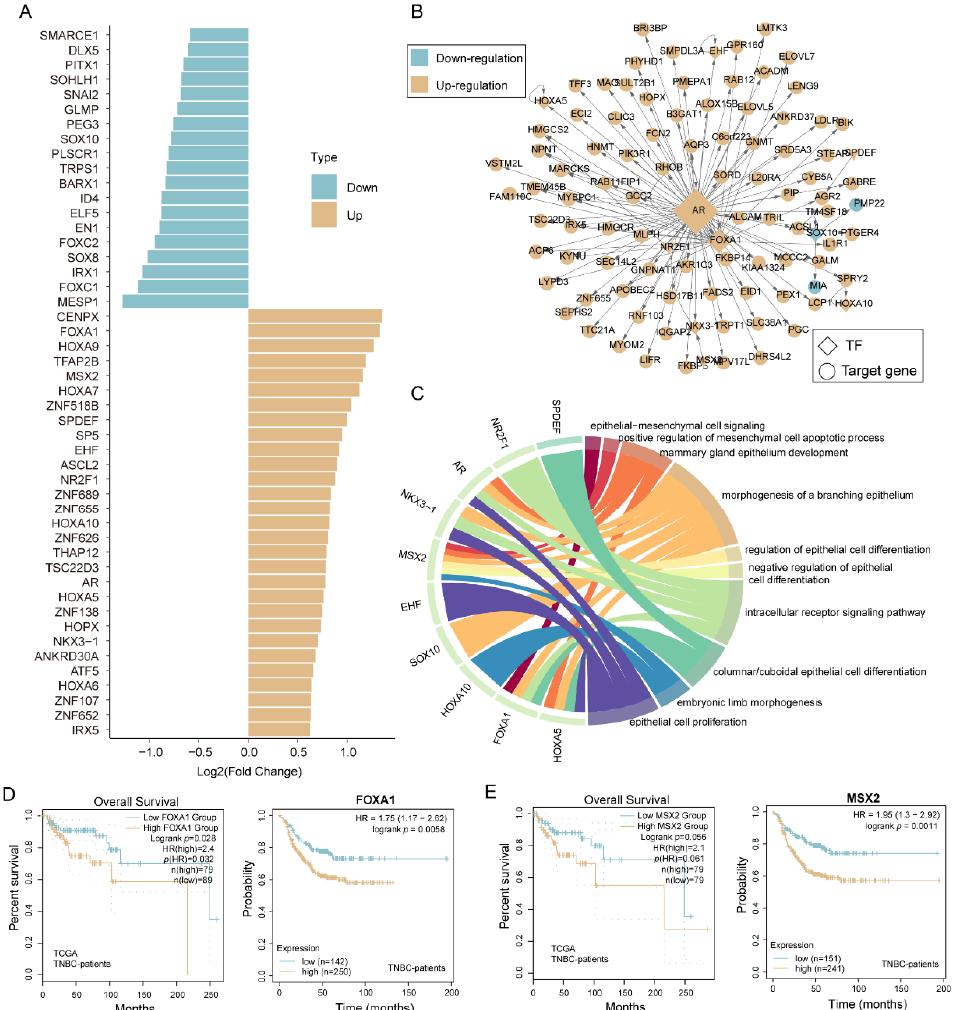
Figure 5. Transcription factor is involved in the EMT process in TNBC. ( A ) Barplot showing differentially expressed TFs between epithelium-like and mesenchyme-like malignant cells. ( B ) TF-downstream gene regulatory network. ( C ) Circosplot showing the relationship between EMT-related TFs and biological pathways. ( D ) Kaplan–Meier curves of TNBC tumor samples stratified by the expression value of FOXA1. The left panel shows the patients collected by TCGA and the right panel shows the patients collected by KMPlotter. ( E ) Same as in ( D ) but stratified by the expression value of MSX2 .